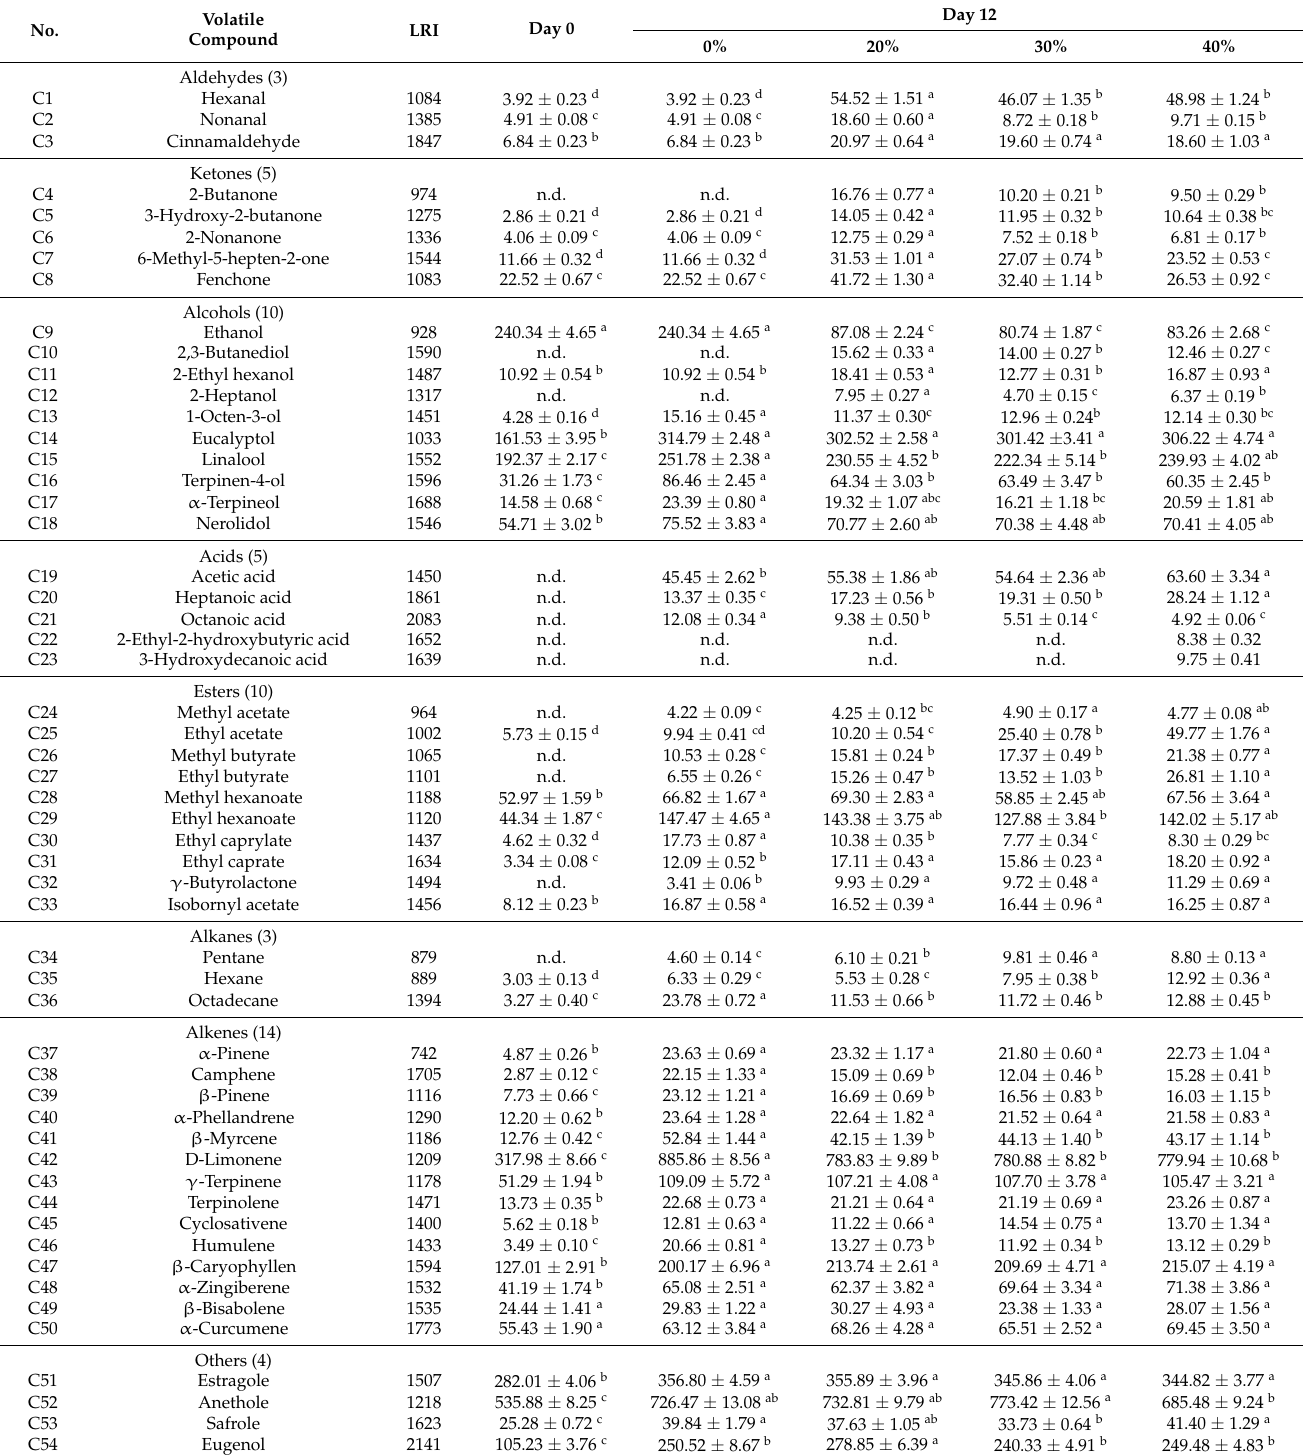
Table 3. Concentration (calculated using the internal standard, µ g/kg) of volatile compounds in traditional dry sausage with different KCl substitution ratios at day 0 and day